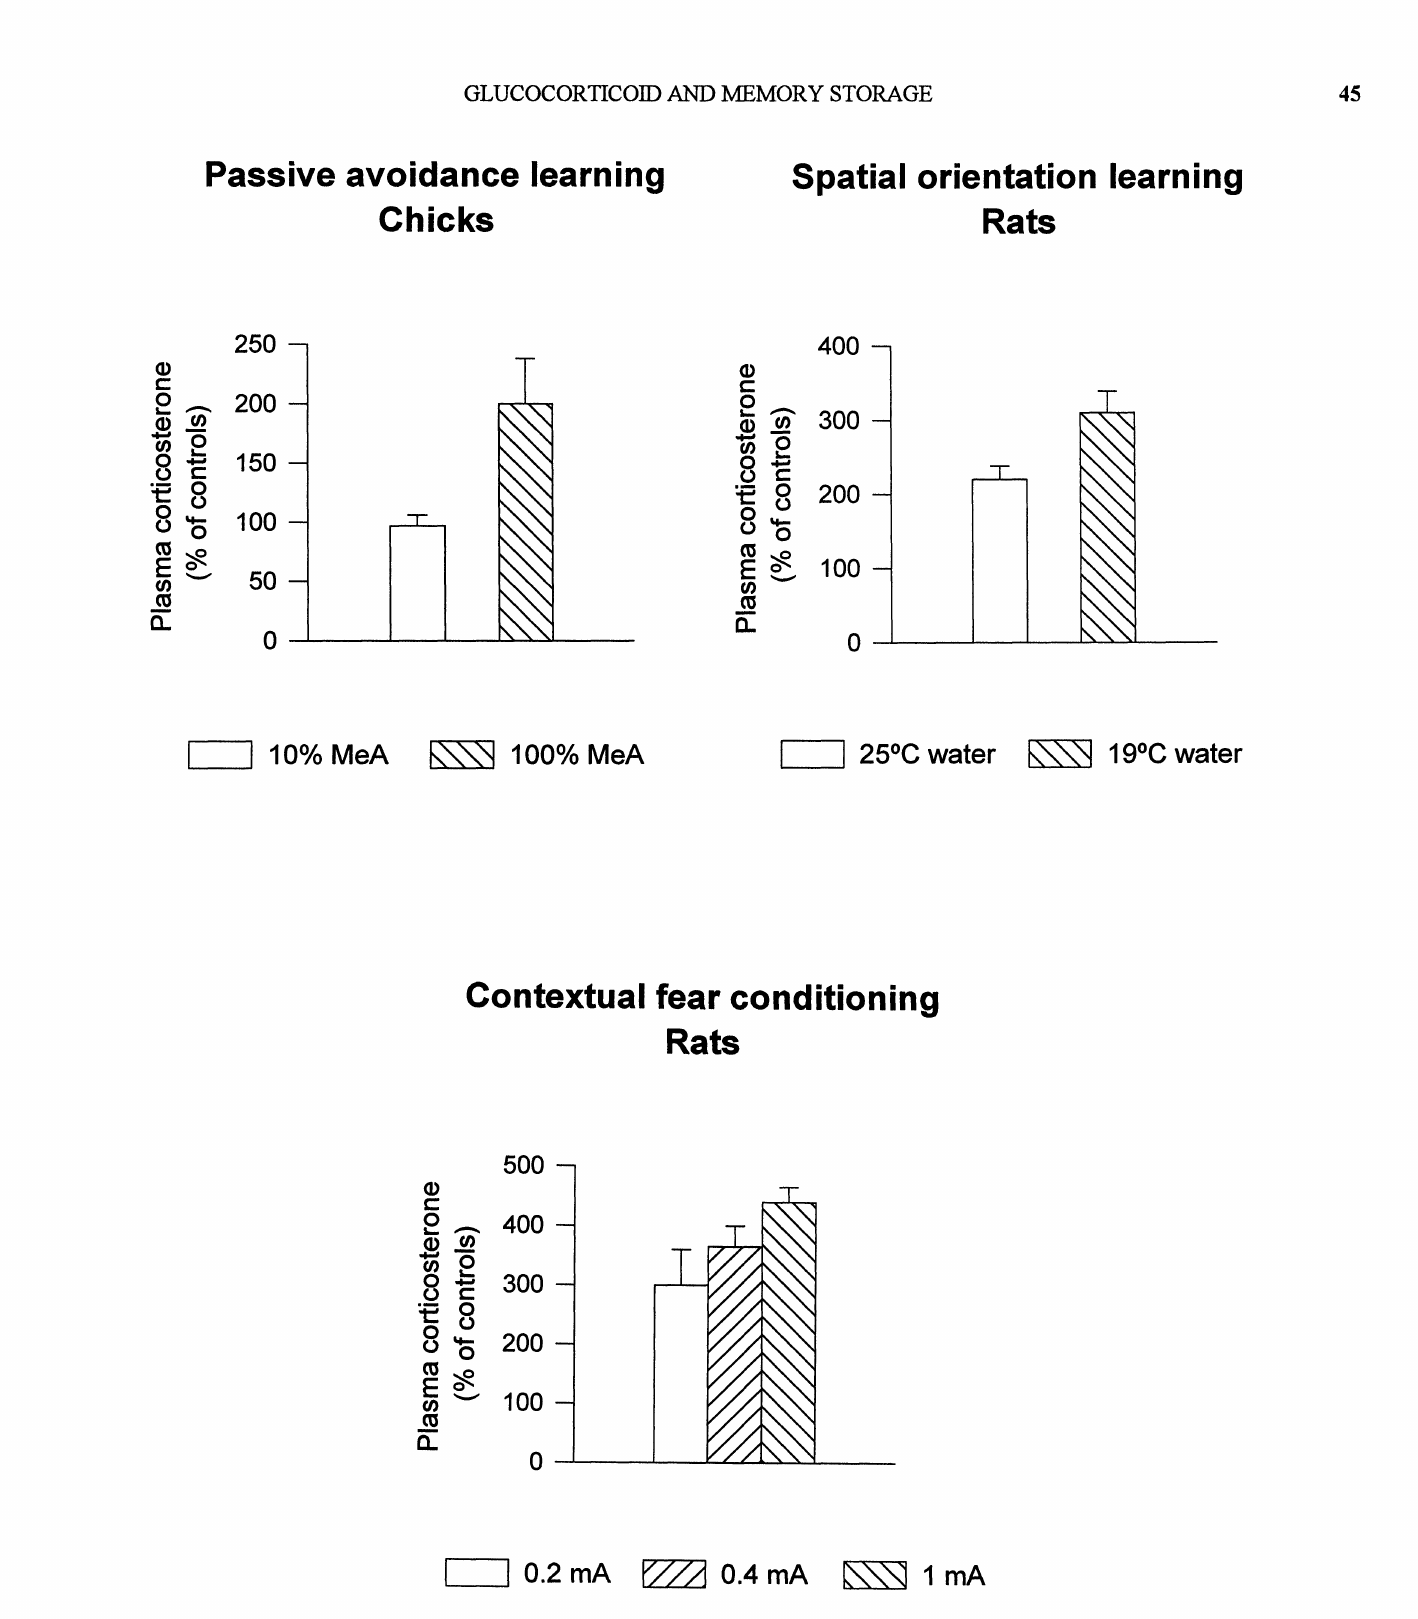
Fig. 1: The effect on post-training plasma corticostemne levels of training rats and chicks at different stimulus intensities. Left: One-day-old chicks trained with either 10% or 100% methylanthranilate (MeA) as the aversive gustatory stimulus [adapted from Sandi & Rose (1997a)]. Middle: Rats trained in the Morris water maze at different water temperatures were evaluated immediately after the first training day [adapted from Sandi et al. (1997)]. Right: Results obtained immediately after training rats on the contextual fear conditioning task with different shock intensities [adapted from Cordero et aL (1998)]. Data represent the mean:t:SEM, expressed as the percentage of untrained control